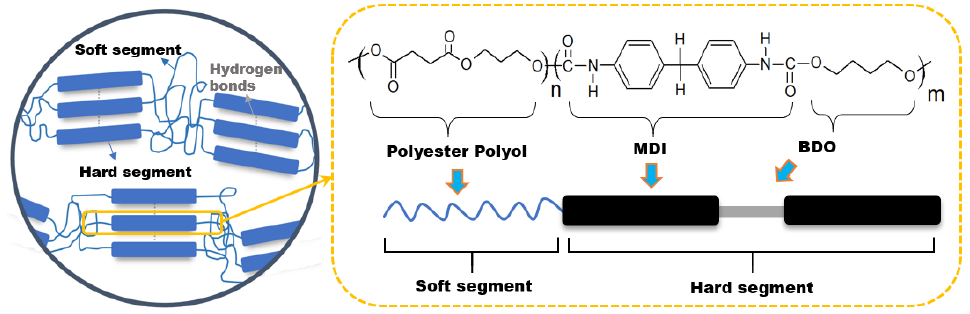
Scheme 1. Schematic diagram of the synthetic mechanism of